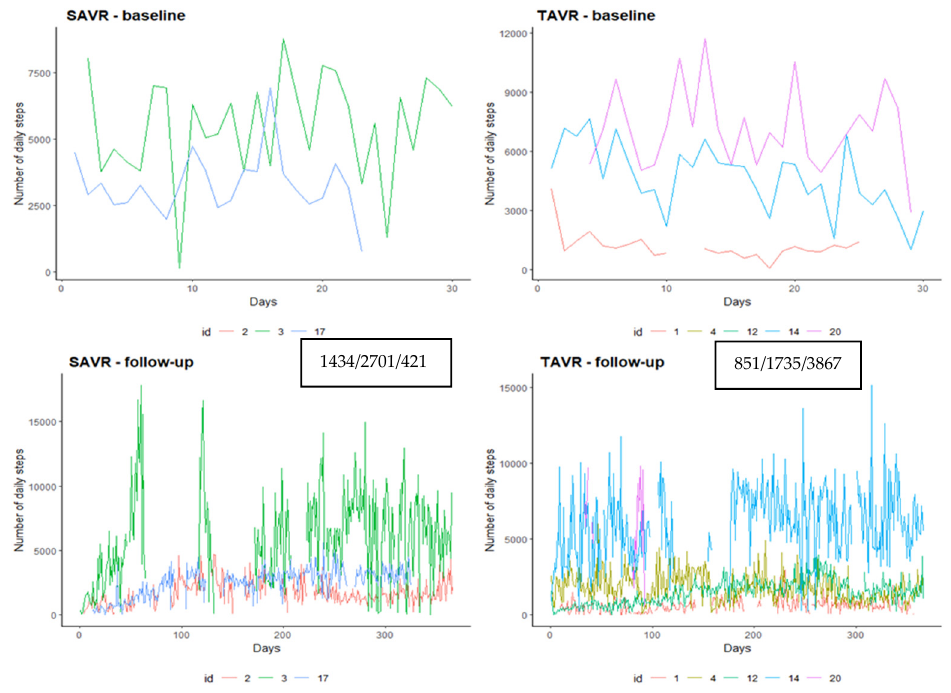
Figure 3. Number of steps trend recorded by the device according to procedure and baseline vs. follow-up period. Data in the box are the I, median and III quartile of number of steps.